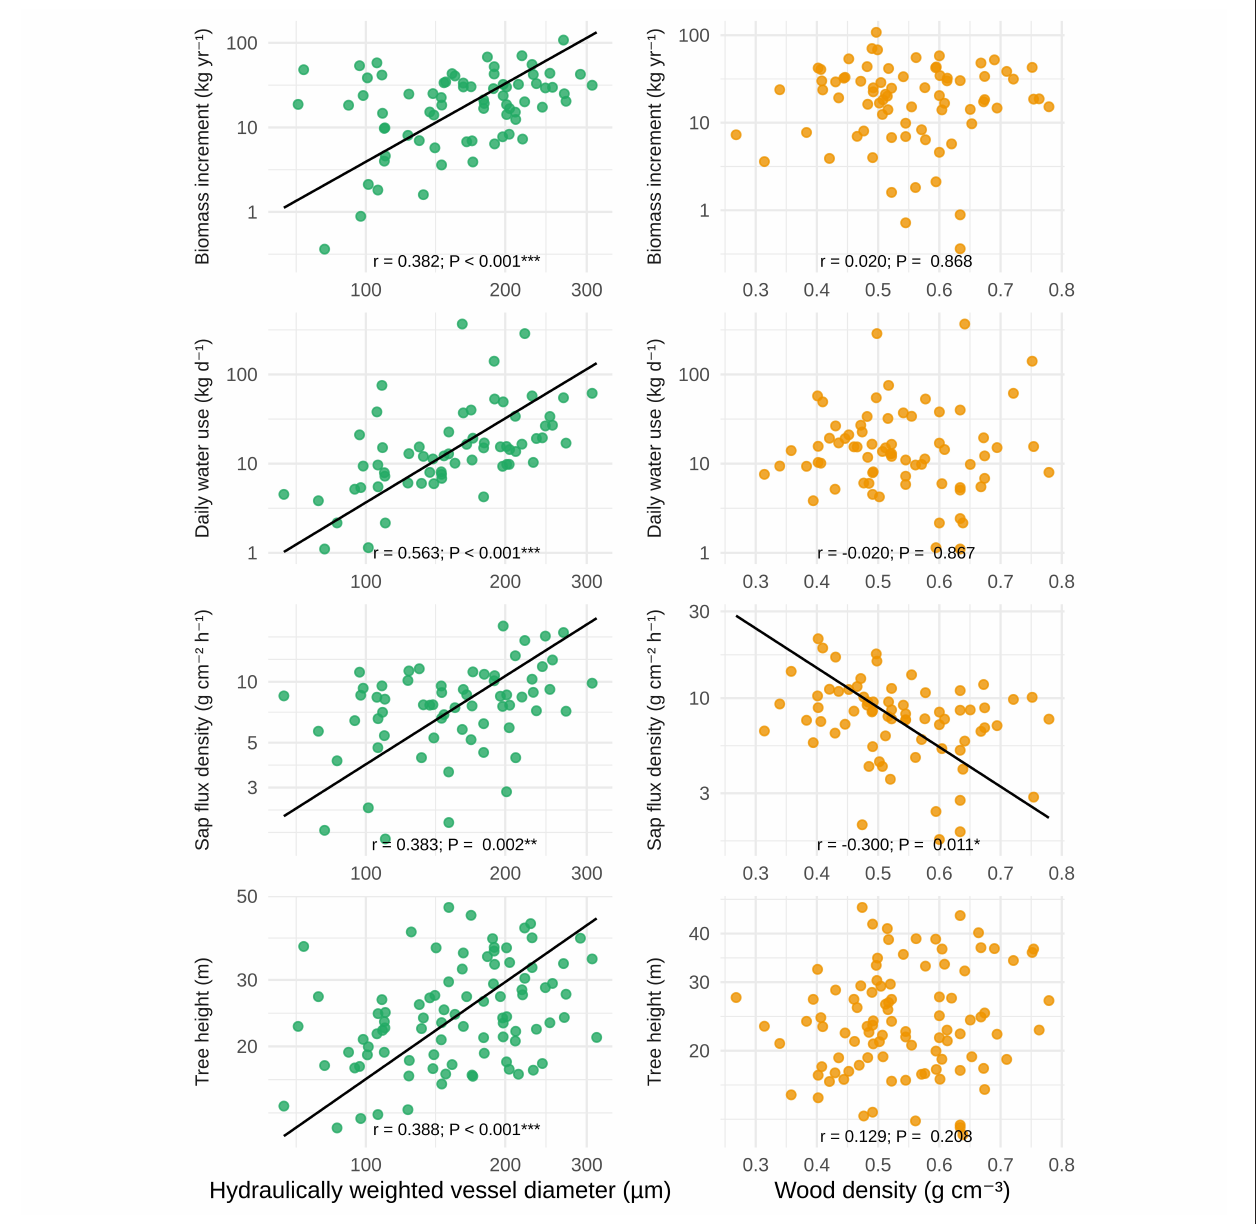
FIGURE 3 | Results of standardized major axis regressions of species-level averages of biomass increment, daily water use, sap flux density, and tree height against hydraulically weighted vessel diameter and wood